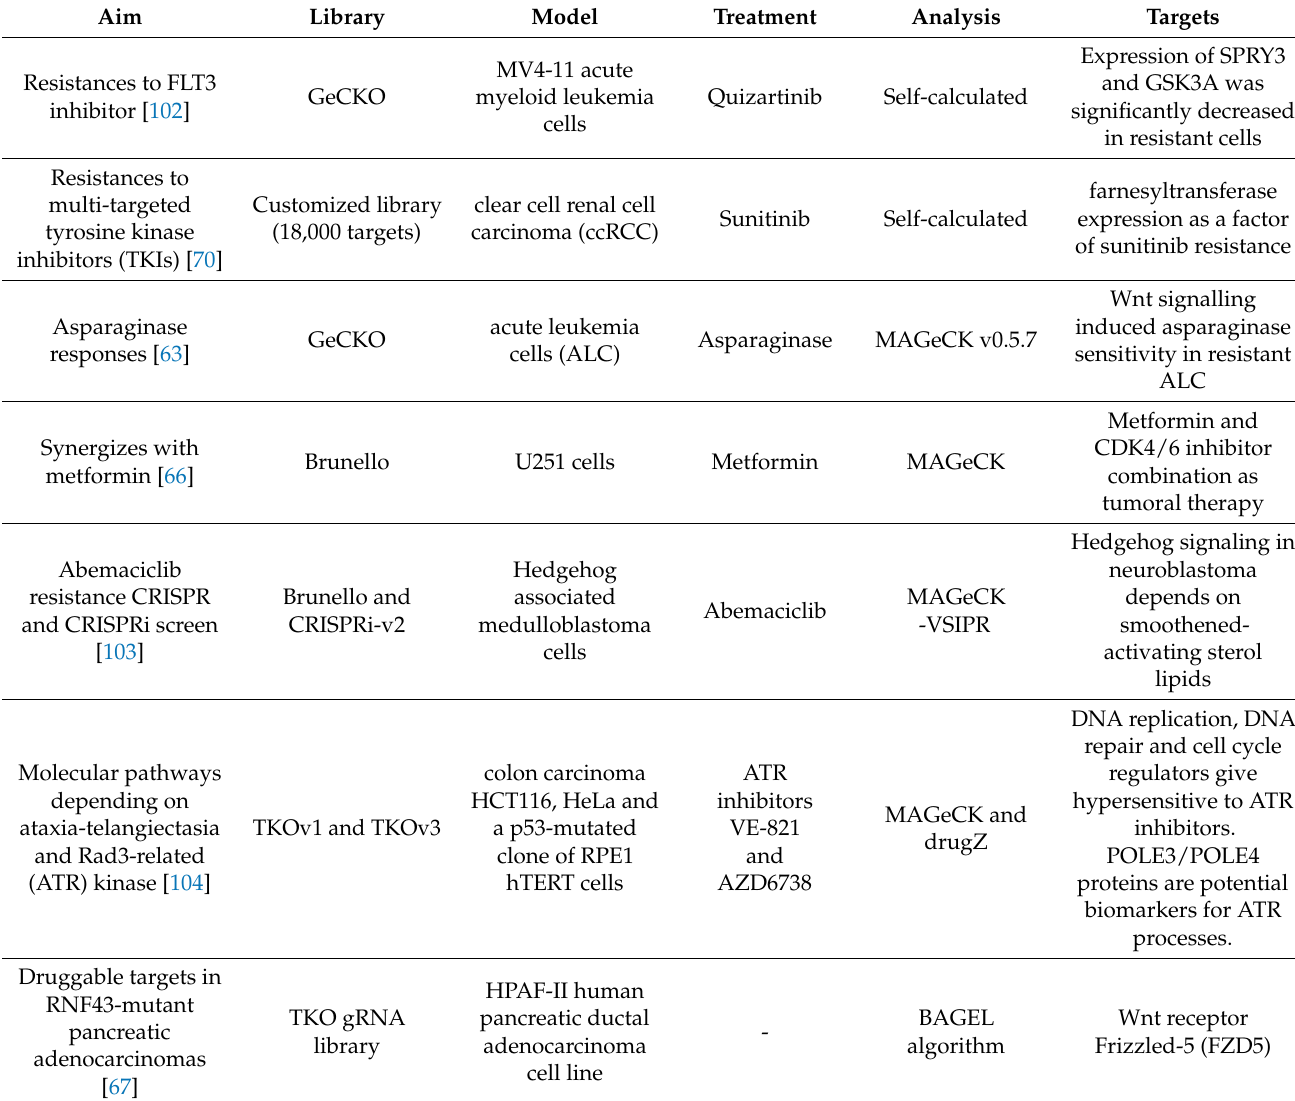
Table 2. Novel drug targets CRISPR